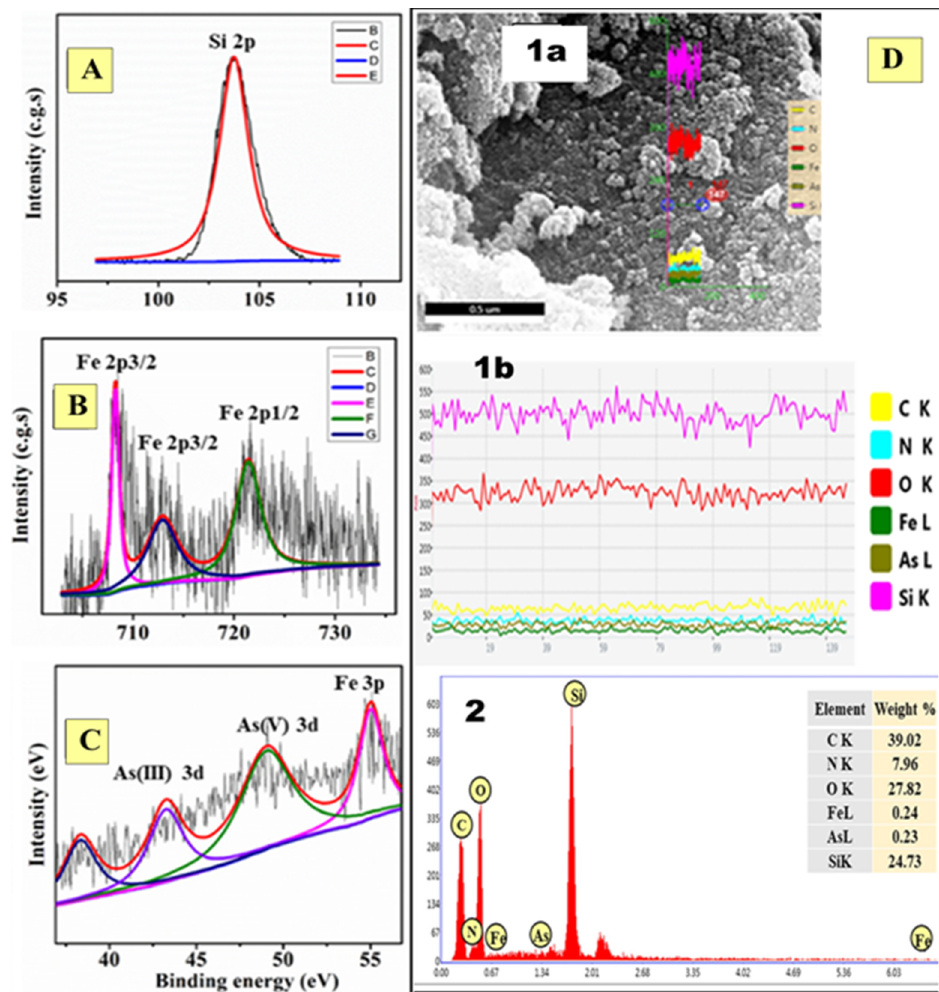
Figure 11. X-ray photoelectron spectrum of As-PBN@SiO 2 after arsenic exposure. ( A ) Identified Si (IV) chemical states in SiO 2 . ( B ) Fe+2 and Fe+3 species XPS peak in PBN@SiO 2 . ( C ) Arsenic species (As(V) and As (III)) at PBN@SiO 2 . ( D ) ( 1a-b ) EDX line scan measurement comprised of an inner SiO 2 and an outer ferric hexacyanoferrate with As(III) enrichment over the PBN@SiO 2 surface. ( 2 ) EDX analysis shows all of the anticipated elements. Table 3. XPS data of PBN@SiO 2 and Arsenic-PBN@SiO 2 .